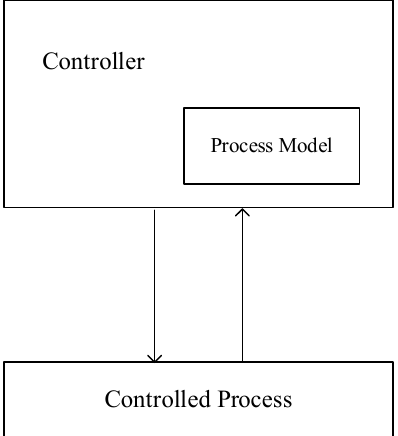
Figure 3. Process model.